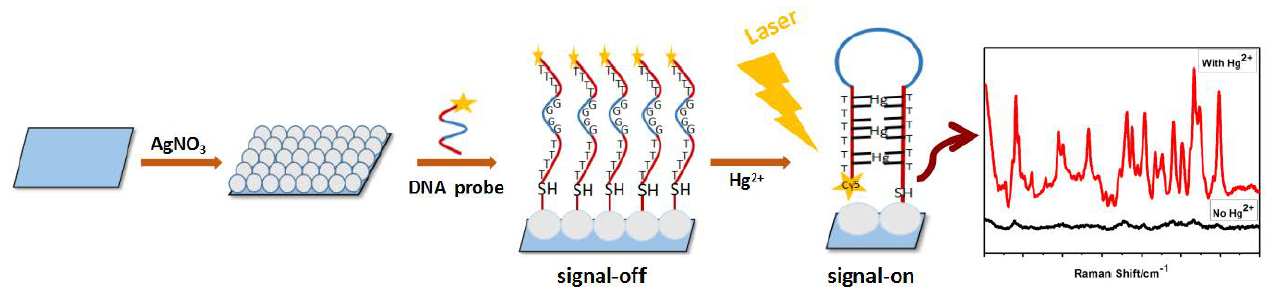
Figure 3. Mechanism of surface-enhanced Raman scattering sensor (SERS) for the detection of mercury ions (Hg 2+ ) using silver colloids.